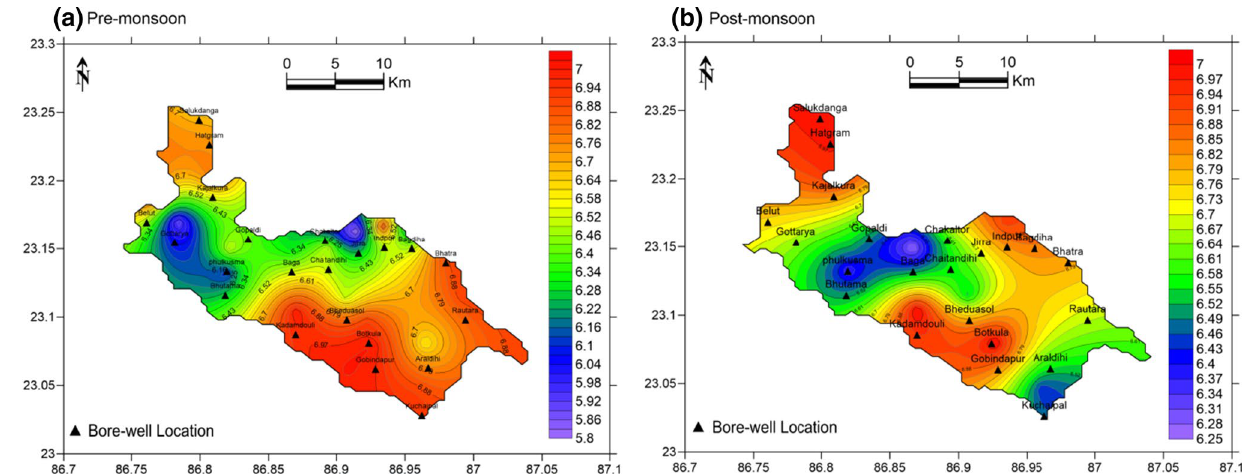
Fig. 5 Spatial distribution of pH a PrM; b PoM